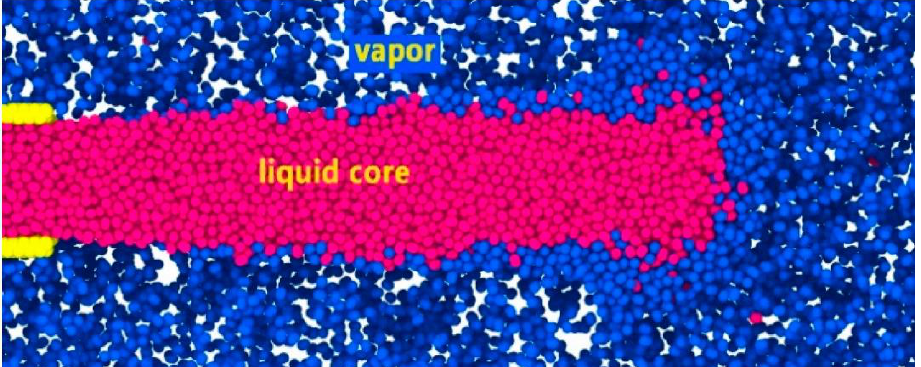
Figure 12. Two-dimensional (2-D) axial sectional view of subcritical jet [19].